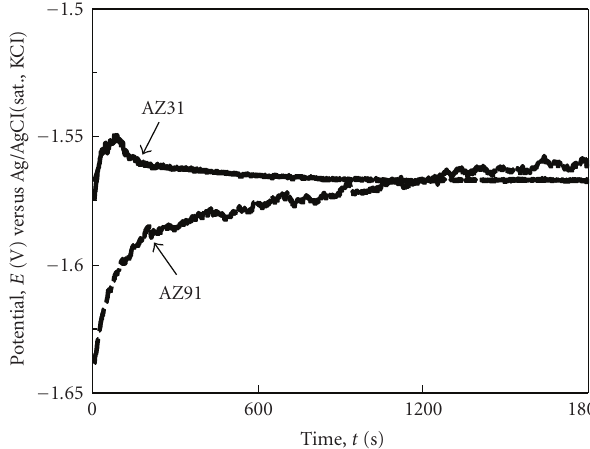
Figure 3: OCP of AZ31 and AZ91 magnesium alloys in 3.5 mass % NaCl